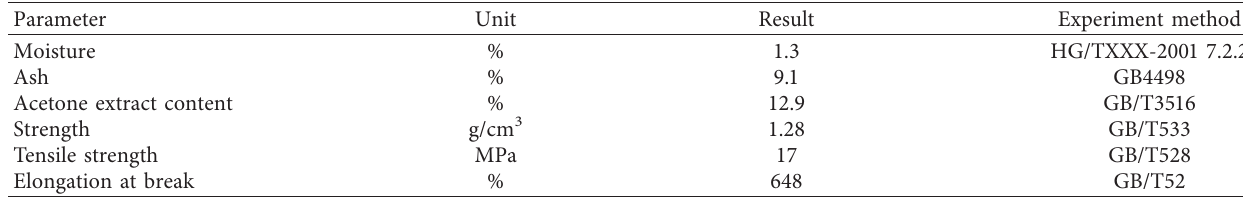
Table 2: Technical parameters of rubber powder.